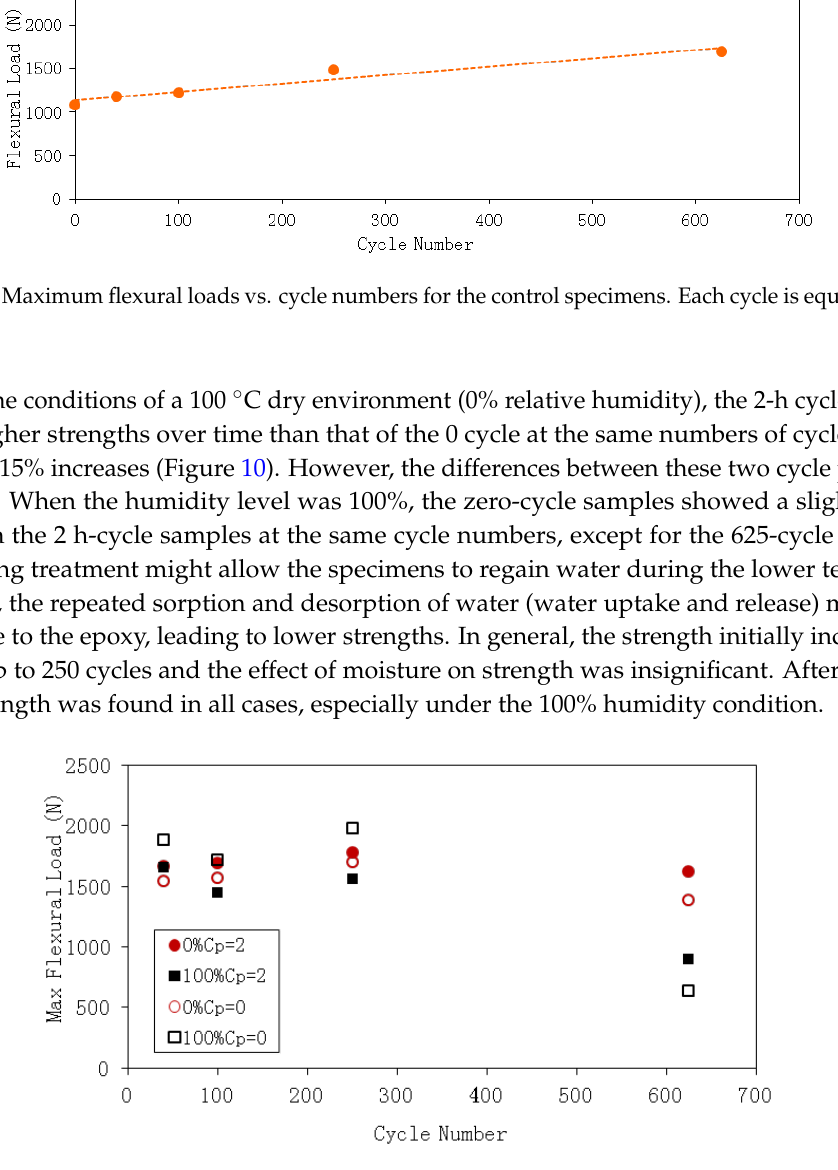
Figure 10. Max. flexural load vs. number of cycles under 100 °C but different humidity levels (0% and 100%) and different cycle periods (Cp = 0 and 2).